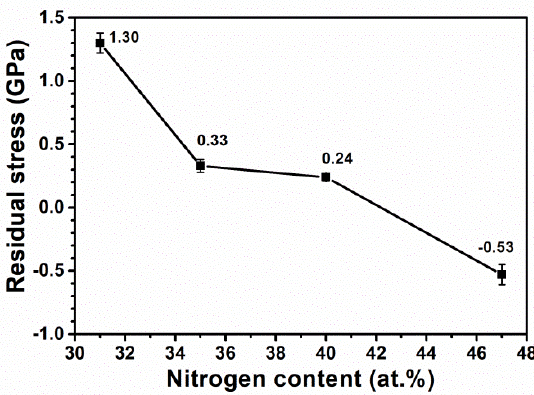
Figure 5. H and E levels of CrWN coatings.